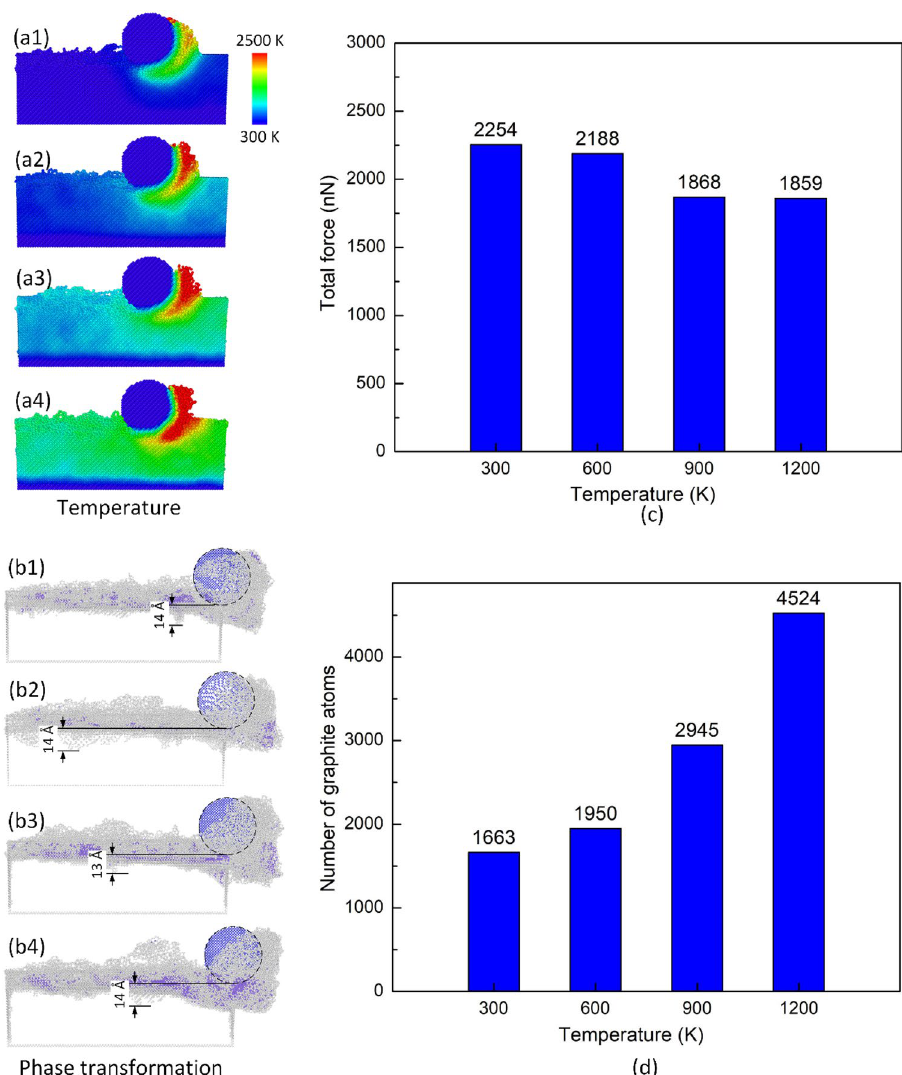
Figure 4. Temperature distribution, phase transformation, force diagram, and number of graphite atoms of different temperatures at 100 m/s, 10 Å depth: ( a1 , b1 ) 300 K, ( a2 , b2 ) 600 K, ( a3 , b3 ) 900 K, and ( a4 , b4 ) 1200 K; ( c ) total force vs temperature; ( d ) number of graphite atoms vs